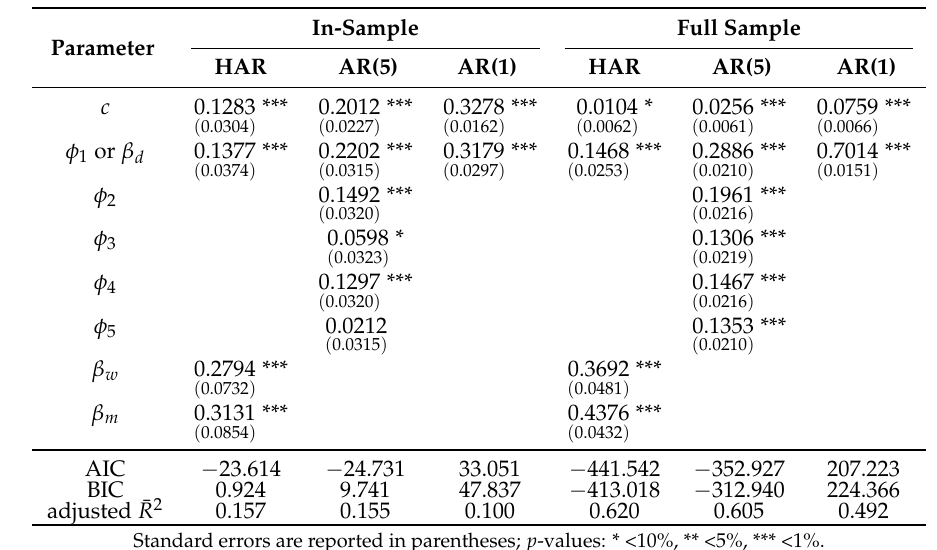
Table 5. Time series model estimates of (cid:98) w t .